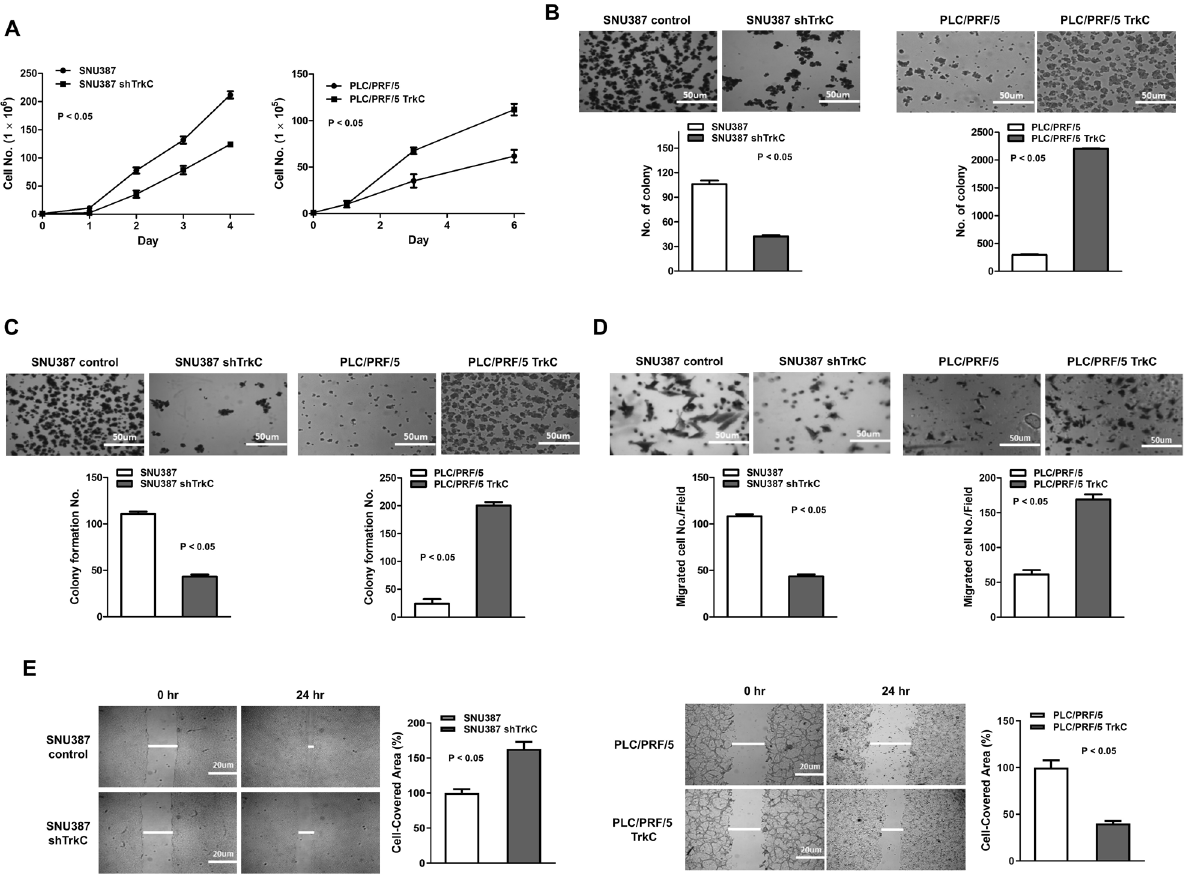
Fig. 2 The ability of TrkC to enhance the tumorigenic and metastatic potential of HCC. A The cell growth analysis of PCL/PRF/5, PCL/PRF/5 TrkC, SNU387 control-shRNA, or SNU387 TrkC-shRNA cells. n = 3. P < 0.05, t -test. Each bar; mean ± SEM. B Phase-contrast images and Soft agar analysis of PCL/PRF/5, PCL/PRF/5 TrkC, SNU387 control-shRNA, or SNU387 TrkC-shRNA cells. n = 3. P < 0.05, t -test. C Phase-contrast images and spheroid formation analysis of PCL/PRF/5, PCL/PRF/5 TrkC, SNU387 control-shRNA, or SNU387 TrkC-shRNA cells. n = 3. P < 0.05, t -test. D